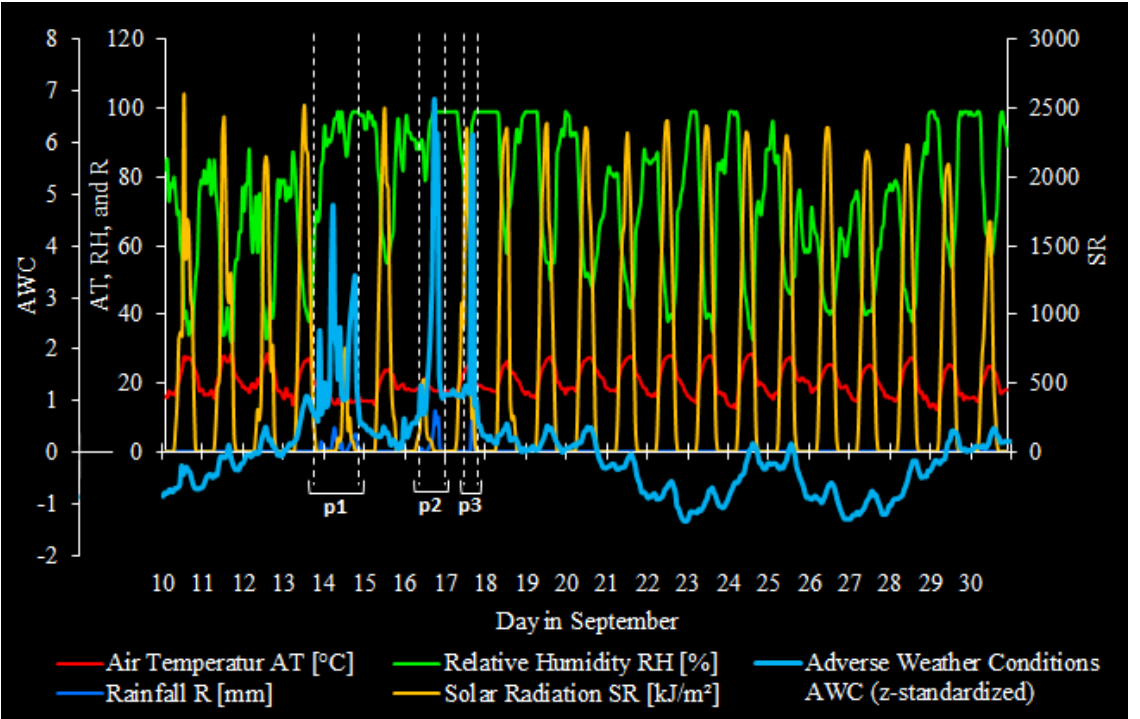
Figure 4. 21 days of adverse weather conditions and its loading meteorological components including three distinct adverse weather periods p1, p2, and